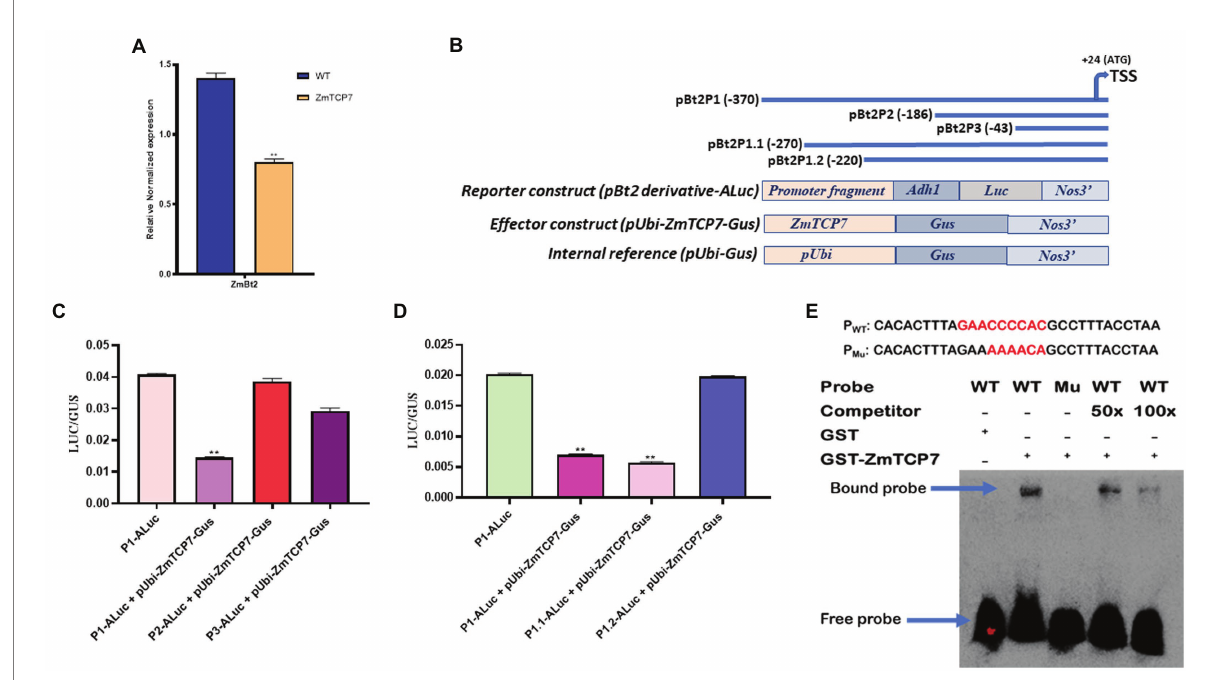
FIGURE 4 Transient overexpression analysis and identification of the binding site of ZmTCP7. (A) Trans-repression analysis of ZmBt2 by transient overexpression of ZmTCP7 in maize endosperm protoplast cells by RT-qPCR; the bars indicate the mean ± SD of three technical replicates. Four independent experiments were performed and the results were found to be consistent in all cases. The significance of the difference between sample test and the control was analyzed by a two-sided t -test (** p < 0.001). (B) Schematic representations of ZmBt2 deletion derivatives (upper panel), reporter, effector, and internal constructs (lower panel) for transient analysis of promoter activity. The deletion positions were indicated relative to the transcription start site (TSS) of the ZmBt2 gene, ZmTCP7 as an effector gene, the first intron of the maize Adh1, the Luc reporter gene, the Gus reporter gene and terminator Nos3 are all indicated; (C,D) Relative influence of ZmTCP7 on the activity of various derivatives of ZmBt2 promoter deletion in the endosperm protoplasts of maize. The bars indicate the mean ± SD of three replicates. Results were found to be consistent in at least five independent experiments. The significance of the difference between each sample test and the control was analyzed by a two-sided t -test (** p < 0.001); (E) Electrophoretic mobility shift assay (EMSA) of the specific binding of ZmTCP7 to the ZmBt2 promoter. EMSA analysis was performed with 30 bp (from − 247 to − 217) biotin-labeled probe (P WT ) or biotin-labeled mutated probe (P Mu ; upper panel) and unlabeled (competitor)